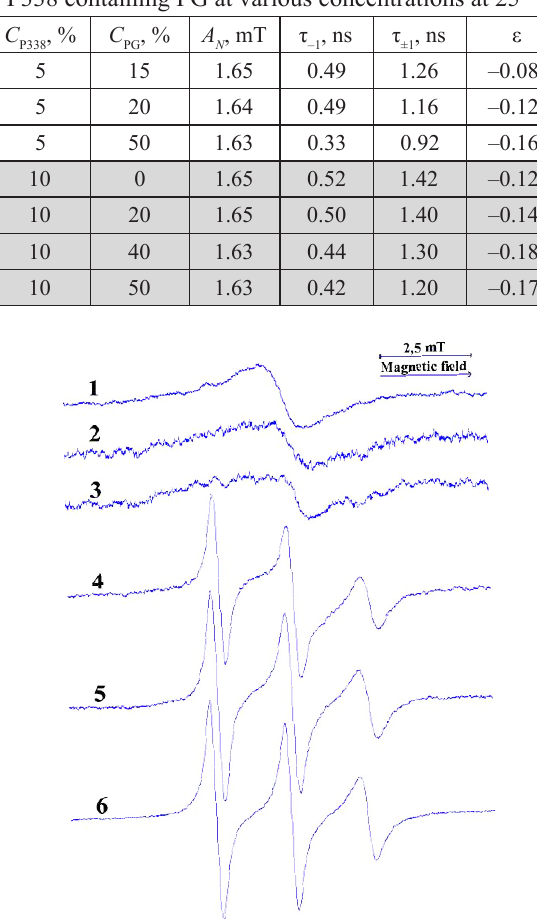
Fig. 16. EPR spectra of spine probe 2 in 5 % solutions of P338 containing PG at concentrations: 1 – 0 %; 2 – 5 %; 3 – 10 %; 4 – 15 %; 5 – 20 %; 6 – 50 %